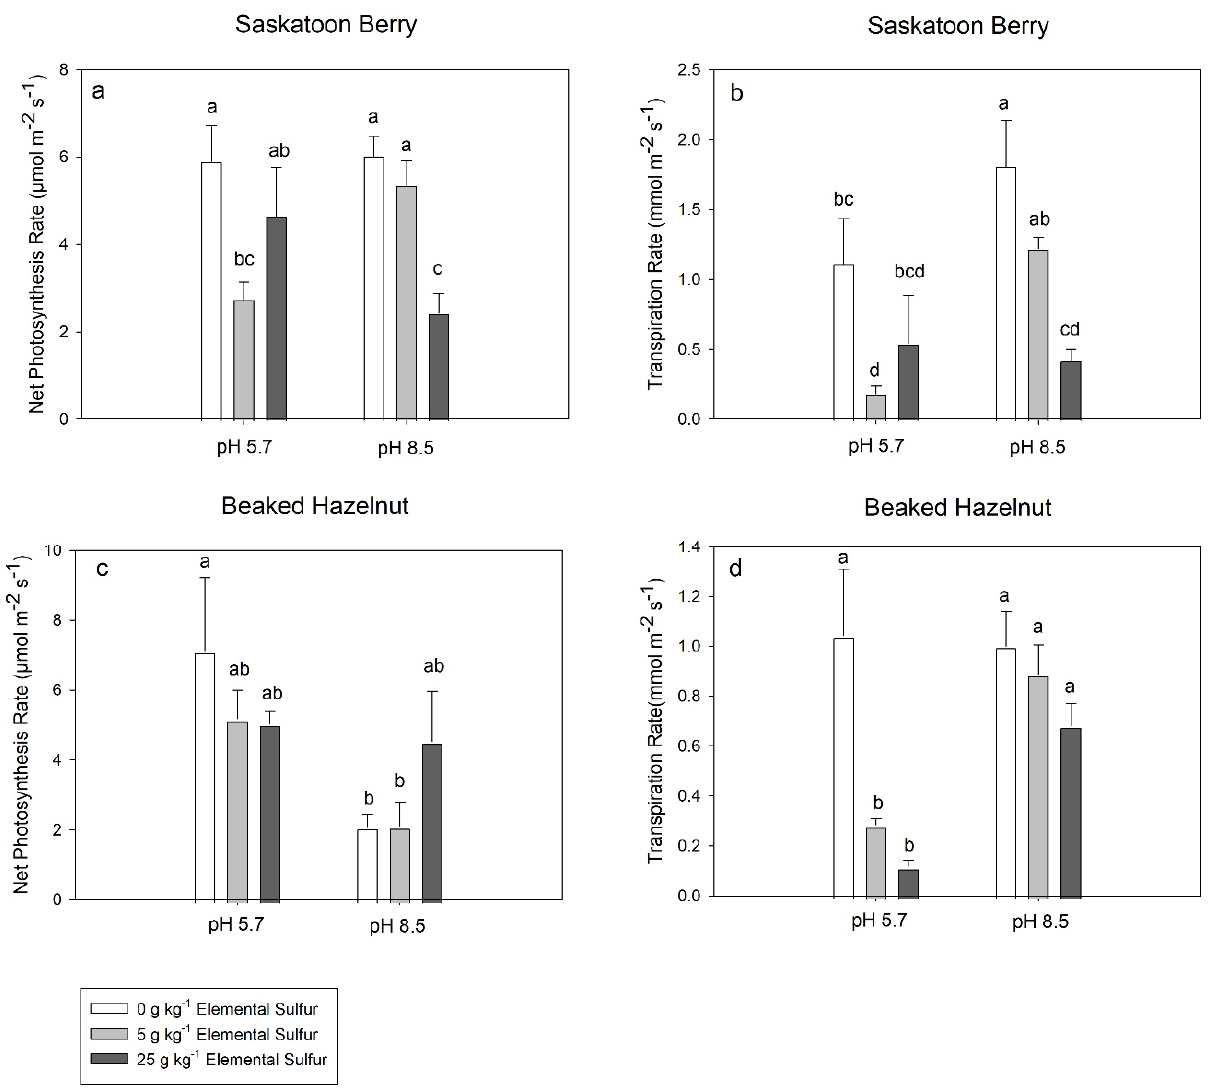
Figure 3. Net photosynthesis (Pn) and transpiration (E) rates in Saskatoon berry ( a , b ) and beaked hazelnut ( c , d ). Plants were grown for two months in the soil of the initial pH 5.7 and 8.5 that was supplemented with 0, 5, and 25 g kg − 1 elemental sulfur. Different letters above the bars indicate significant differences ( α = 0.05) between treatments determined by Tukey HSD test. Means ( n = 6) ± SE are shown.